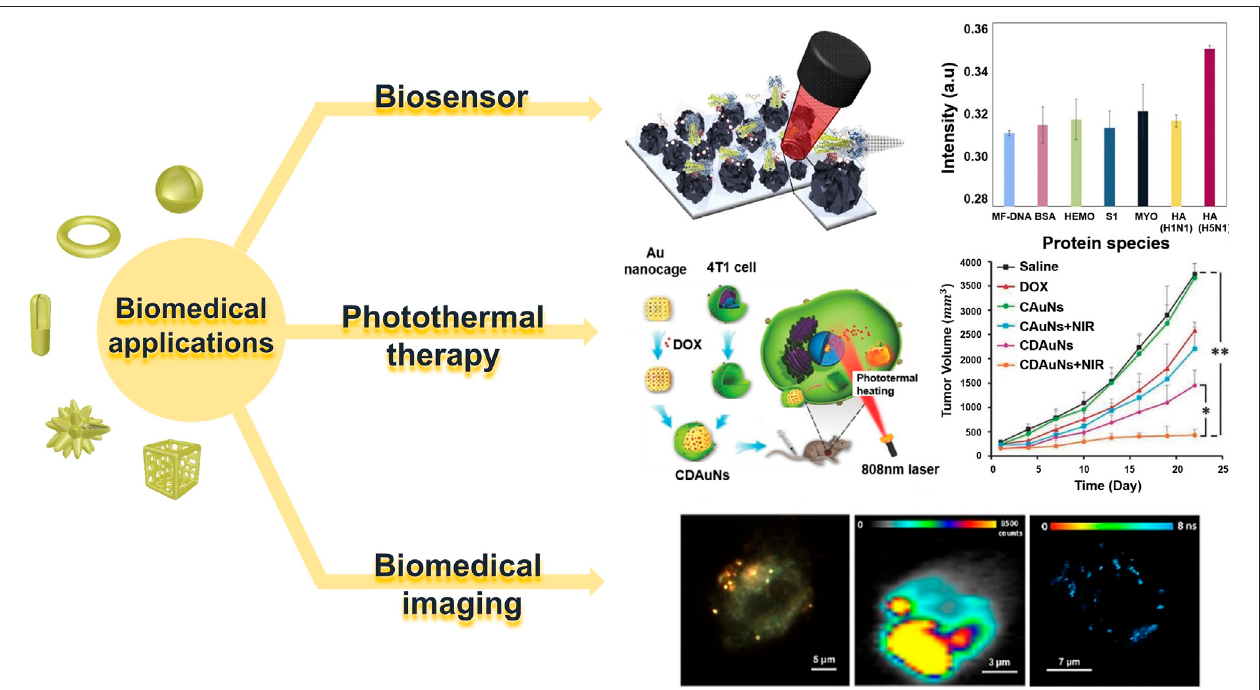
FIGURE 7 | Various biomedical applications of hollow gold nanostructures. Reprinted with permission from Lee et al. (2019). Copyright 2018, Elsevier. Reprinted withpermission from Sun et al.(2017). Copyright 2016,WILEY-VCHVerlag GmbH and Co.KGaA, Weinheim.Reprinted withpermissionfrom Nagy-Simon et al.(2017). Copyright 2017, American Chemical Society.